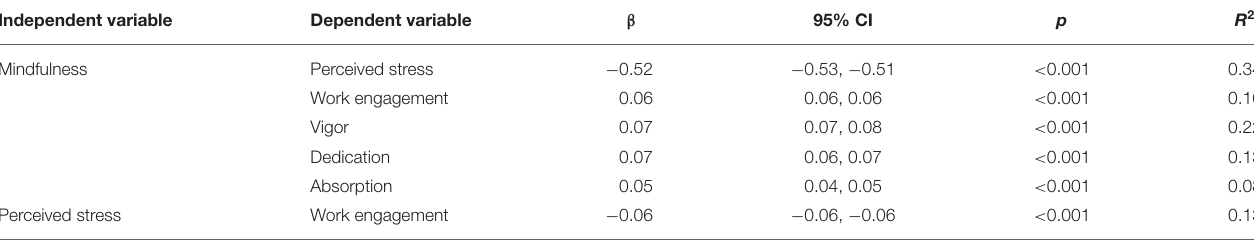
TABLE 1 | Univariate regression model results of the relationship between mindfulness, stress, and work engagement ( n = 16,697). Independent variable